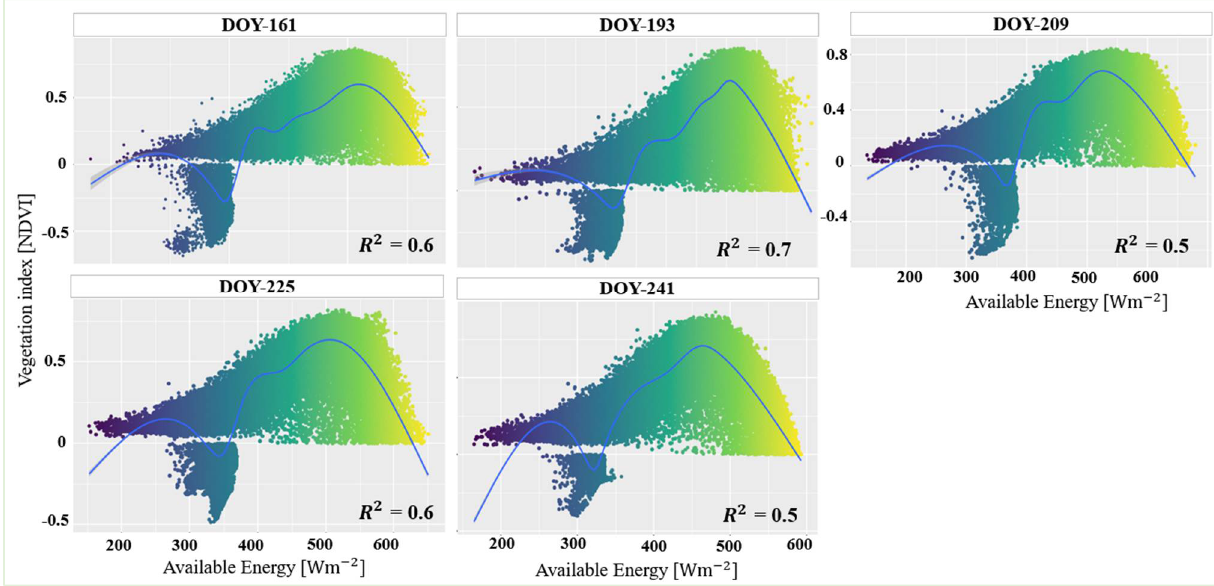
Figure 7. Magnitude variation of Yanqi vegetated canopy density (NDVI) related with available energy under the studied period.